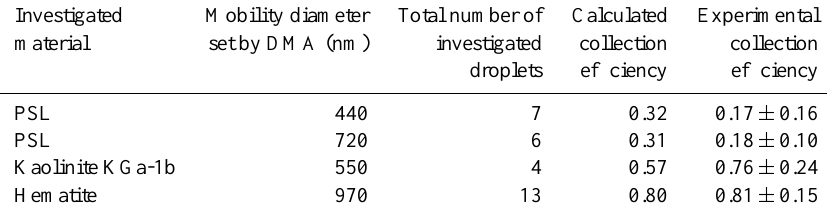
Table 1. Comparison of theoretical and experimental collection efficiency for PSL microspheres, kaolinite KGa-1b, and hematite particles.